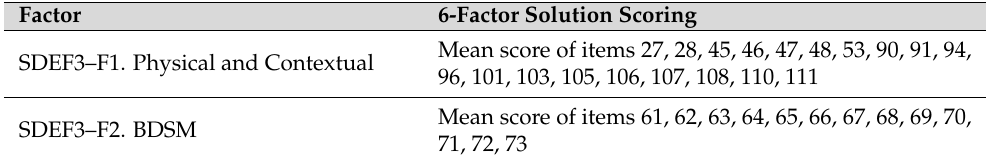
Table A3. SDEF3 6-factor solution scoring.